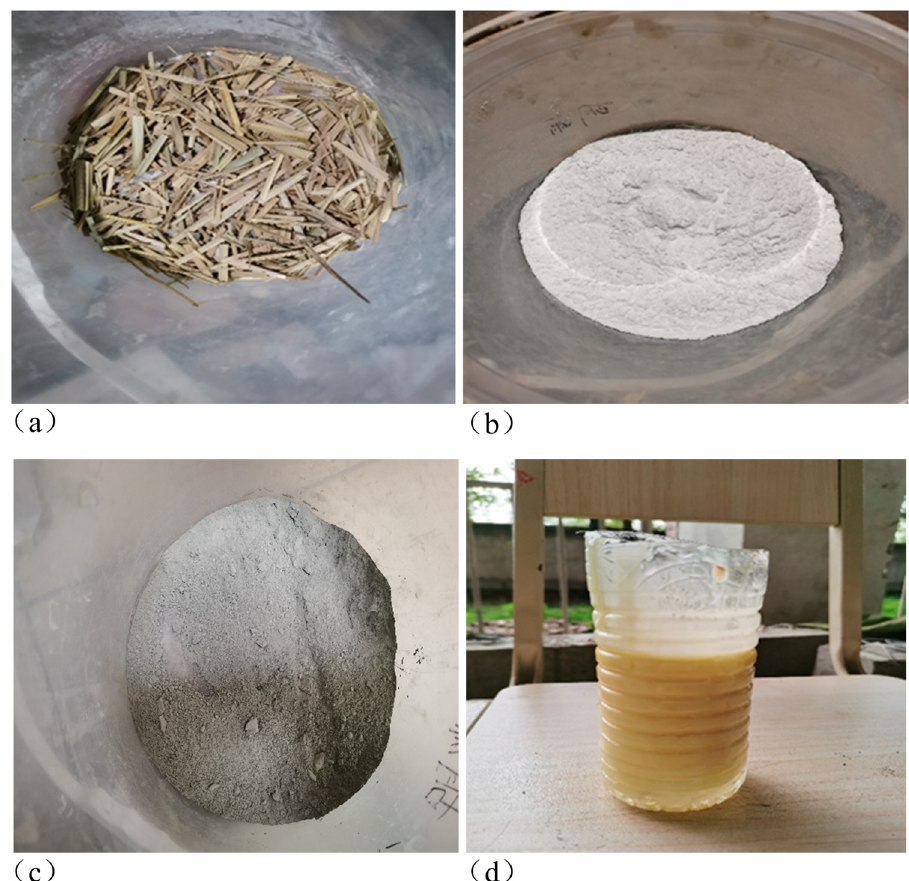
Figure 6: Modi fi ed material: ( a ) straw; ( b ) starch; ( c ) cement; and ( d ) epoxy